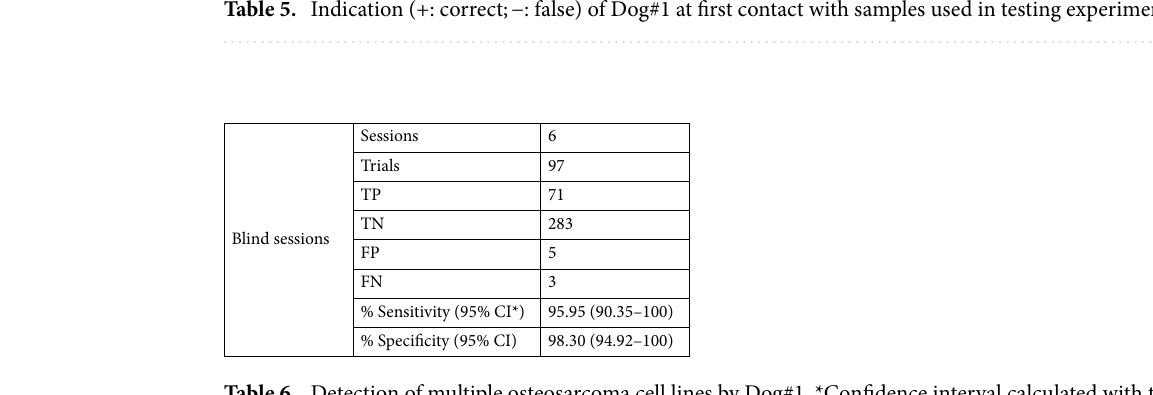
Table 5. Indication (+: correct; −: false) of Dog#1 at first contact with samples used in testing experiments.